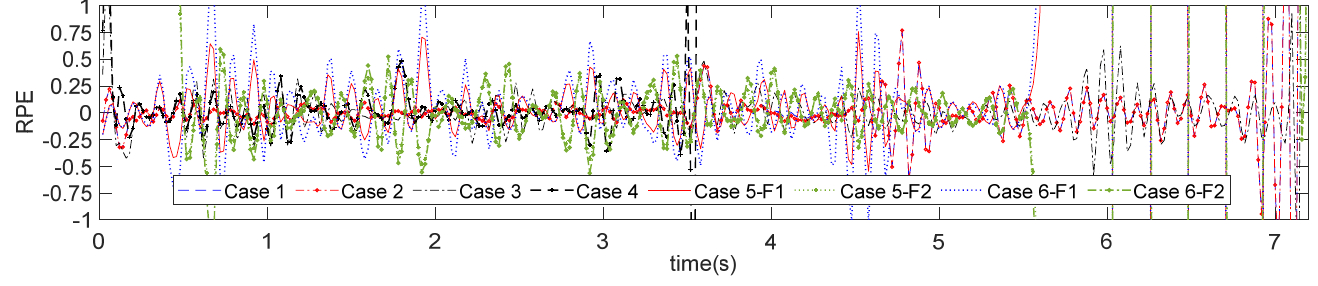
Figure 7. RPEs of moving force identification.